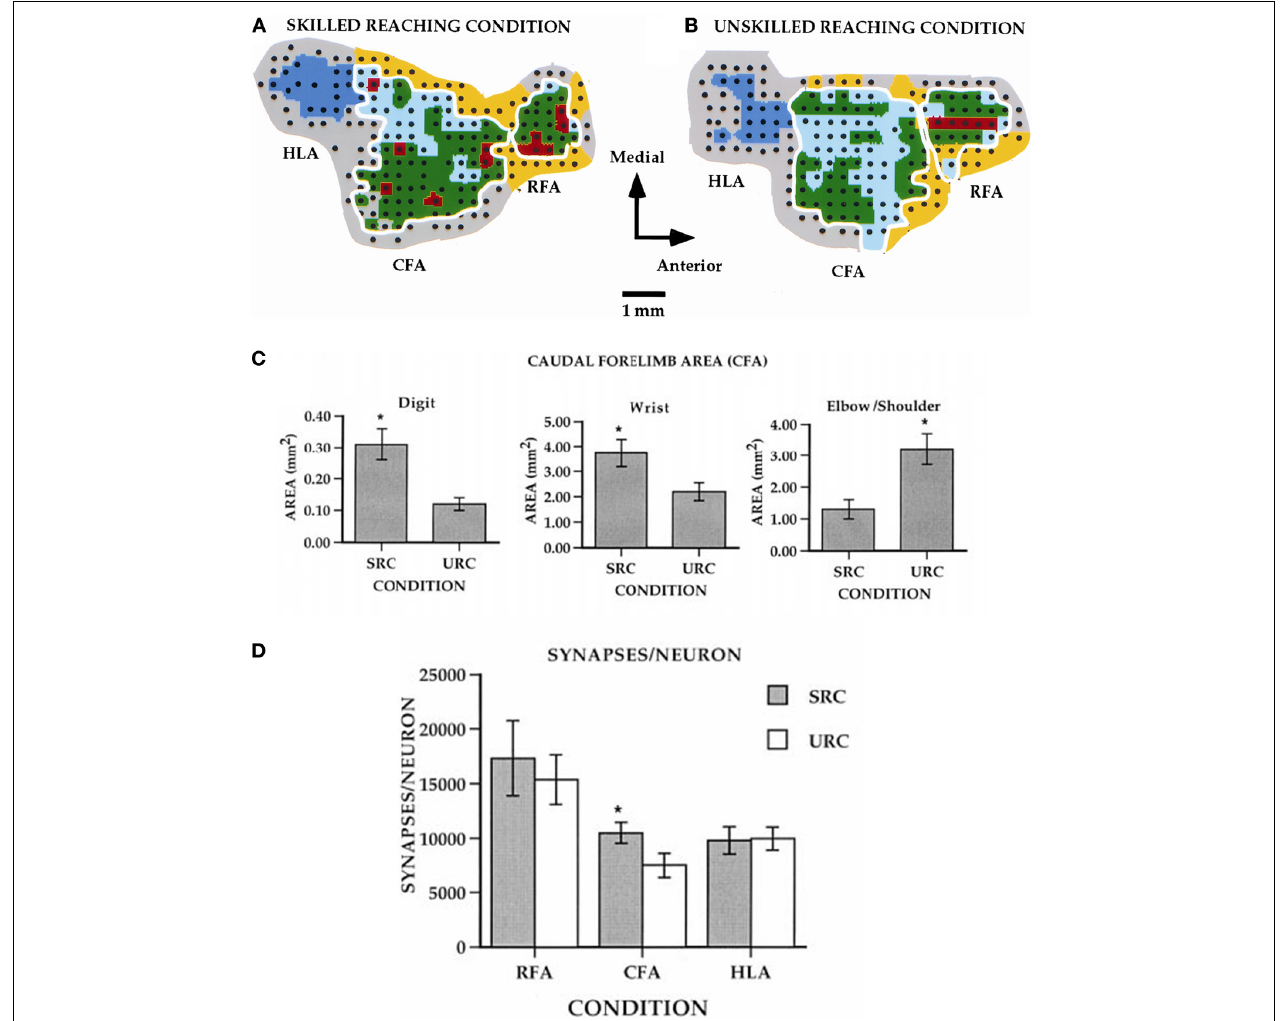
FIGURE 3 | Differential effects of skill vs. use. (A) ICMS-derived motor map (digit, red; wrist, green; elbow/shoulder, light blue) of a rat that learned a skilled reaching movement. (B) ICMS-derived motor map of a rat that learned to press a bar. The two forelimb areas are outlined in white. The caudal forelimb area (CFA) is separated from the rostral forelimb area (RFA) by a band of head/neck representations (yellow).